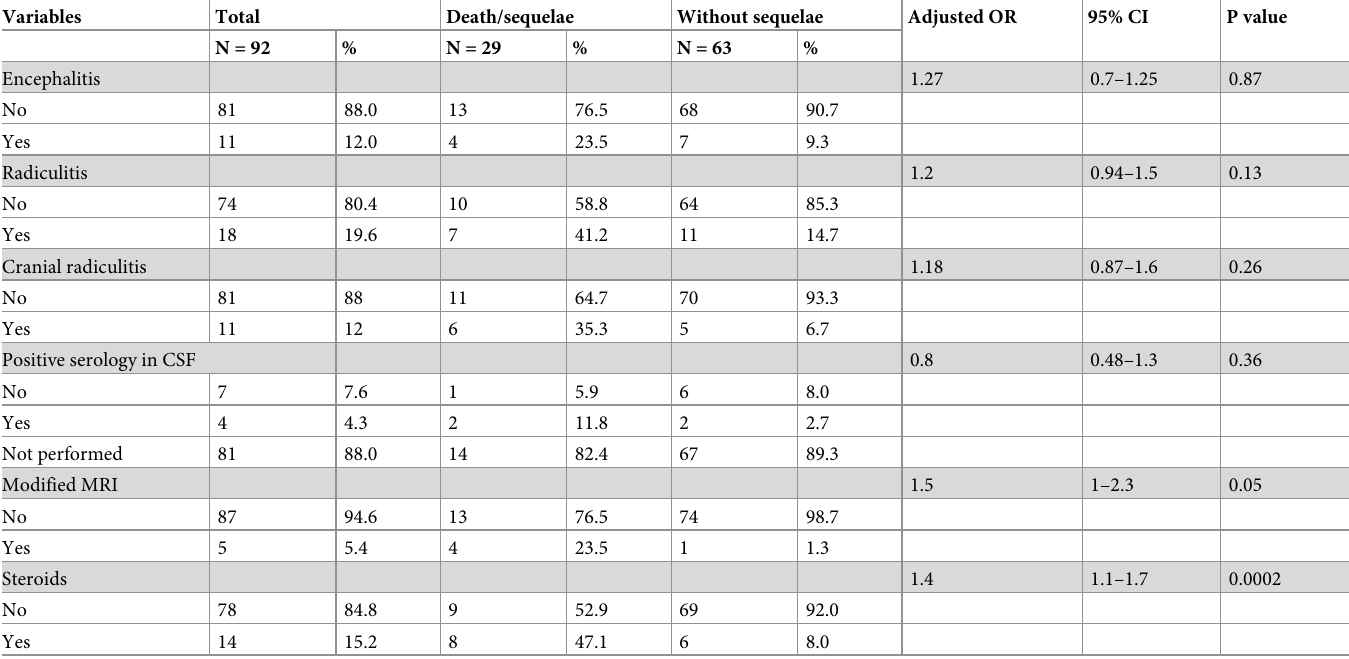
Table 6. Final model of New Caledonian cases of EM according to death/sequelae, n = 92. Variables